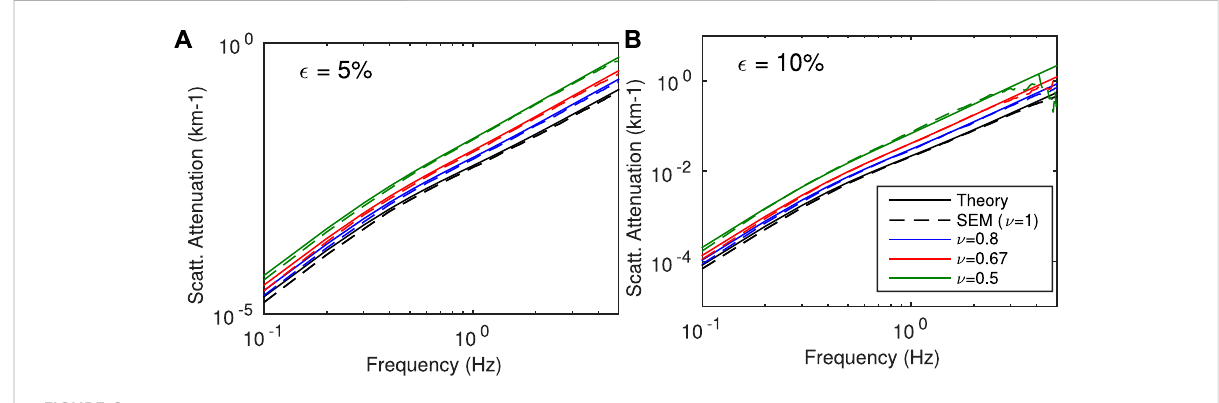
FIGURE 6 Comparison of scattering attenuation between SEM (dashed lines) and the analytical solution (solid lines). SEM solution corresponds to the ensemble-space average approach and the theory is given by the solution of Eq. 7. (A) Cases ε = 5%; (B) Cases ε =